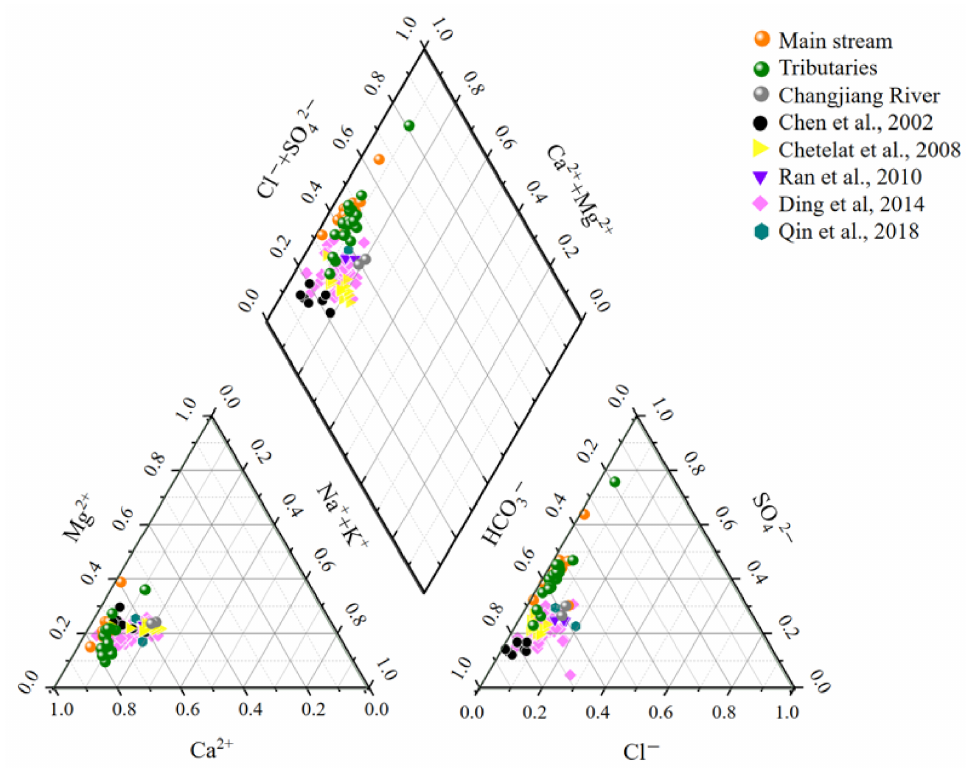
Figure 2. Piper diagrams representing the percentages of hydrochemical species in Chishui River (including 2 water samples collected in Changjiang River before and after the Chishui River drained into, the solid gray circle) and Changjiang River (data reported by previous studies